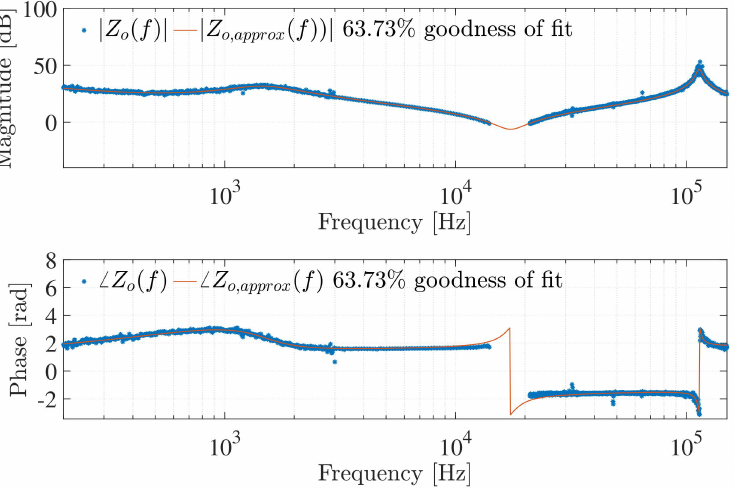
Figure 22. Magnitude and phase response of the analytical Laplace-domain approximation of the measured output impedance, Z o , approx ( f ) , compared to Z o ( f )